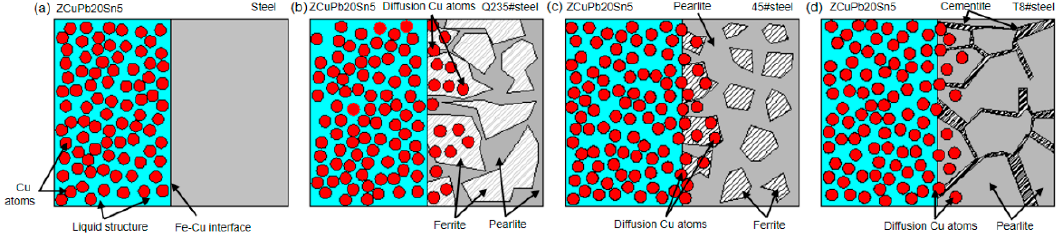
Figure 12. Diffusion mechanism of the interface of the carbon steel/copper bimetallic composites obtained using rapid induction heating: ( a ) interface before pouring, ( b ) interface of the Q235 steel and ZCuPb20Sn5, ( c ) interface of the 45 steel and ZCuPb20Sn5, and ( d ) interface of the T85 steel and ZCuPb20Sn5.